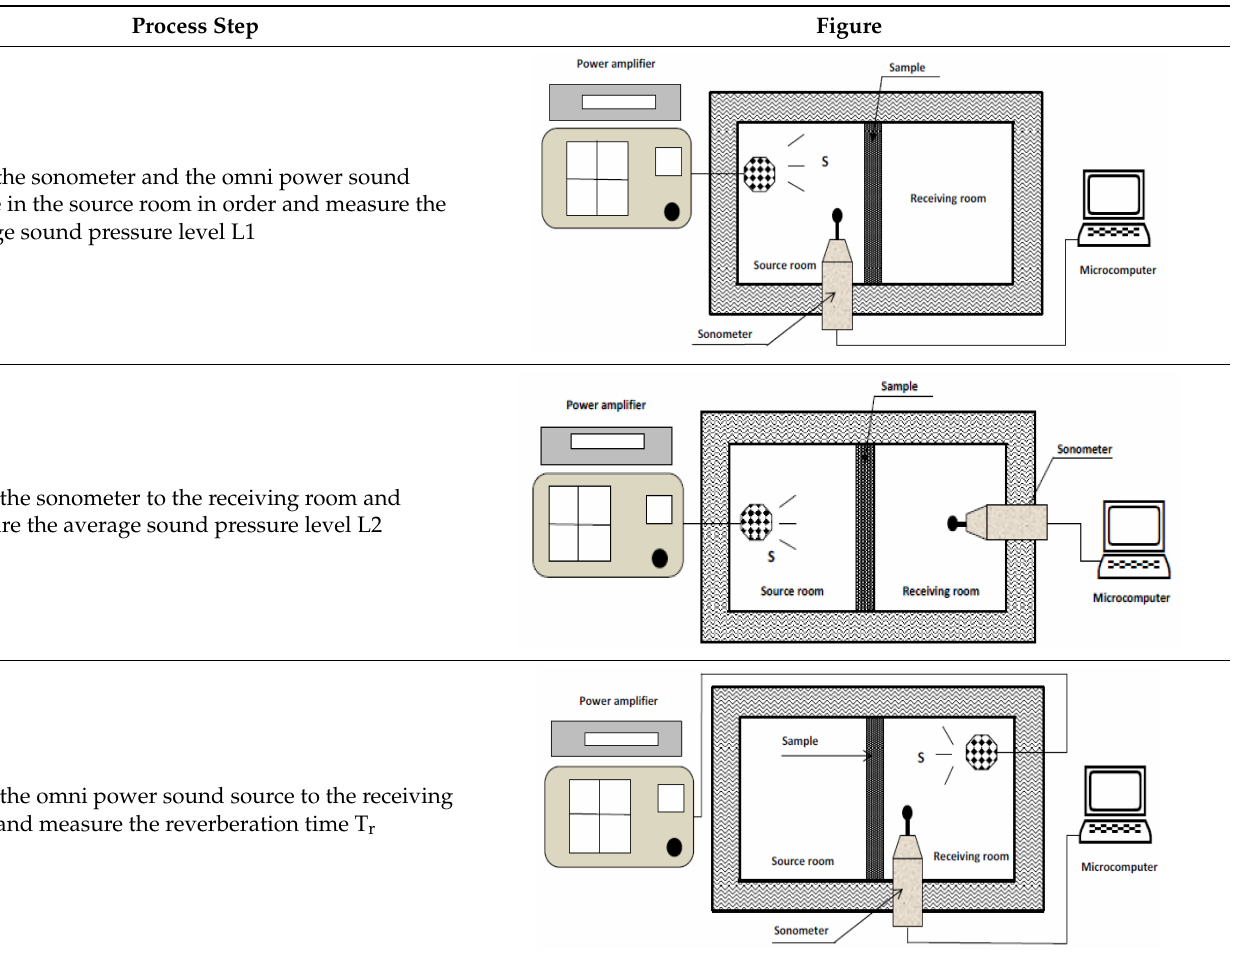
Table 4. Sound reduction index measuring